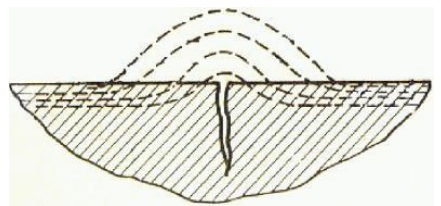
Figure 1. Self-magnetic leakage field in a surface crack.